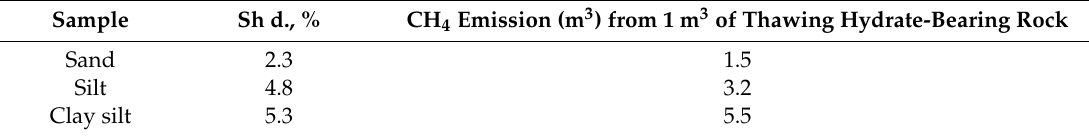
Table 4. Amount of methane (CH 4 ) released upon warming of frozen hydrate-bearing samples.